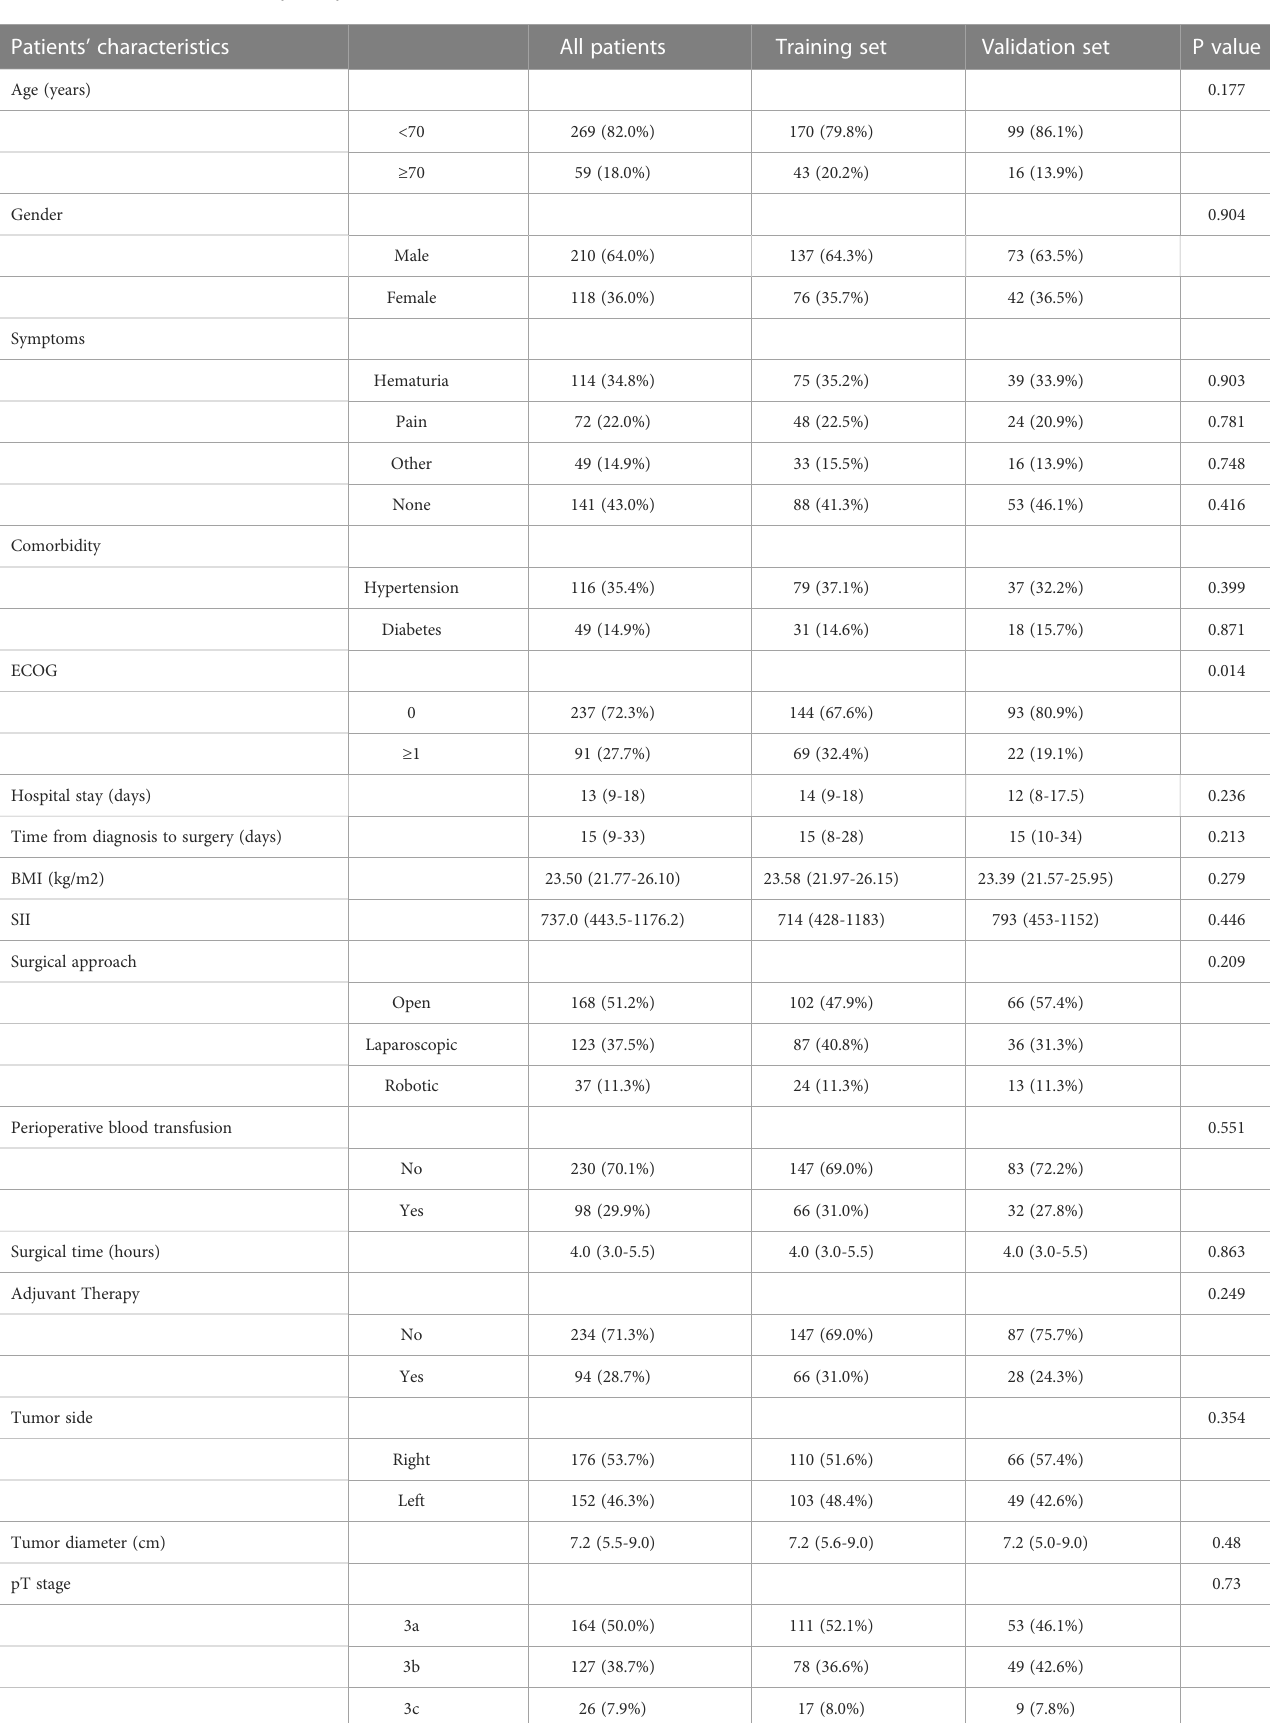
TABLE 1 Patients ’ characteristics